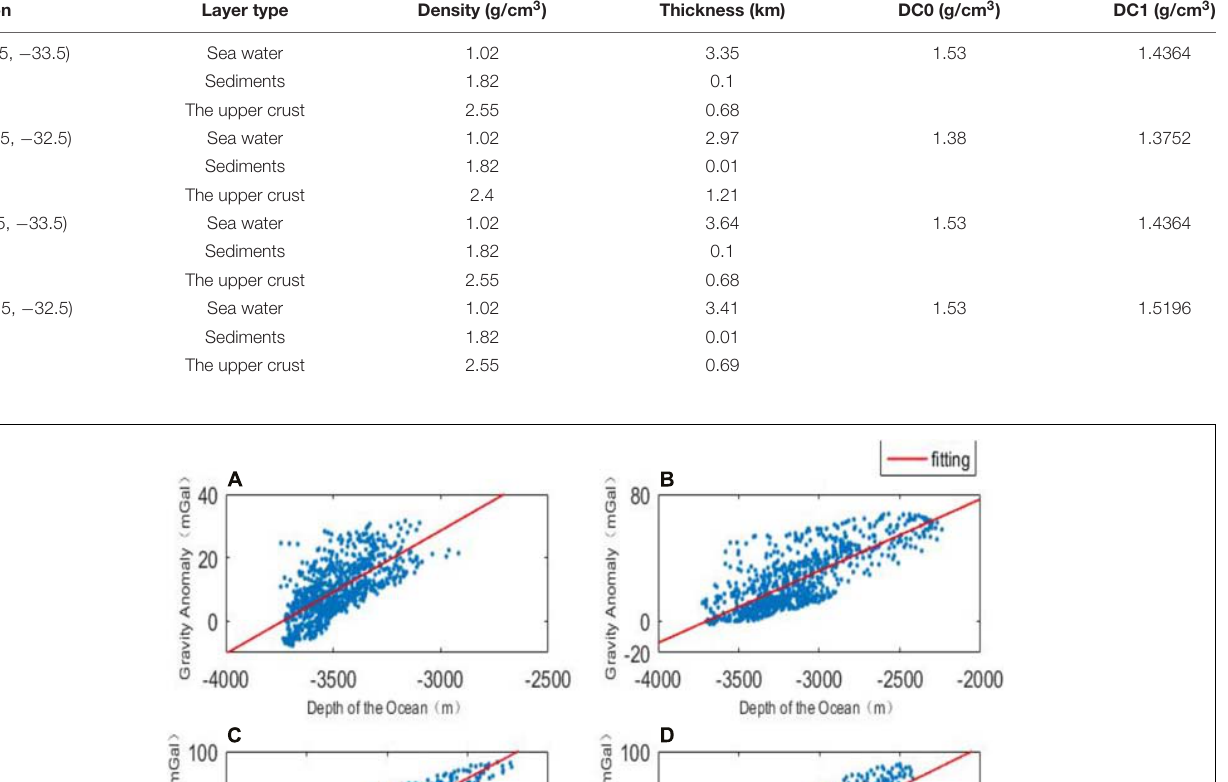
TABLE 1 | Density contrasts from CRUST1.0.